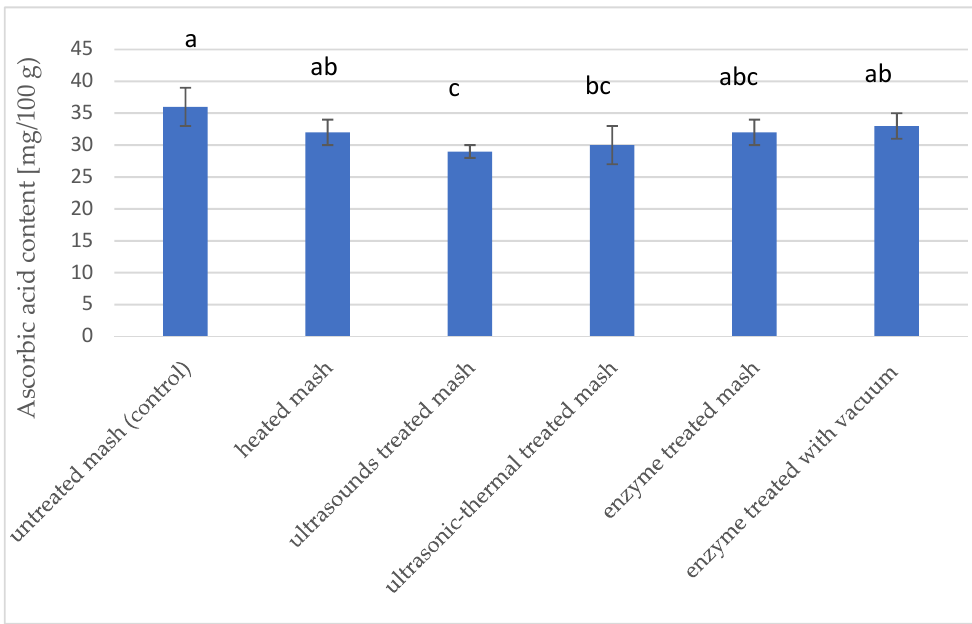
Figure 2. Effect of mash treatment on ascorbic acid content (values are means ± standard deviation; the different letters (a–c) indicate a significant difference at p < 0.05 for analysis of variance (ANOVA) and post-hoc analysis performed with Tukey’s test). Table 1. Effect mash treatment on the content of non-anthocyanin phenolic compounds (mg/100 g f.